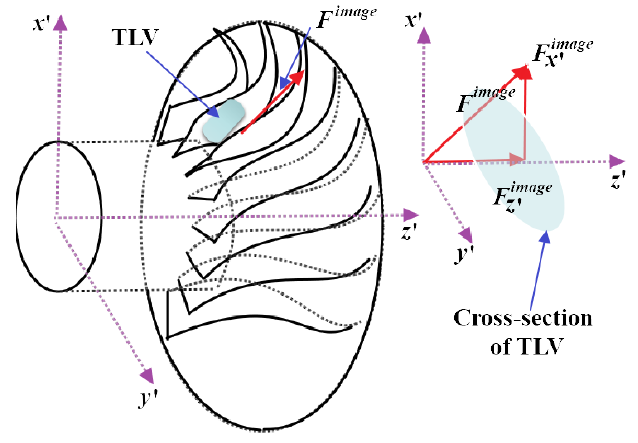
Figure 7. Schematic of the flow passage constriction effect.